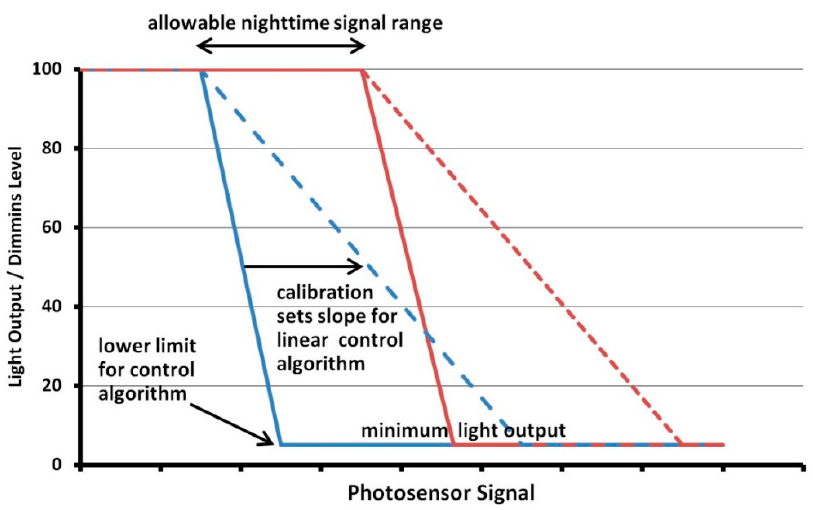
Figure 5. A linear proportional control algorithm may have limits on its available